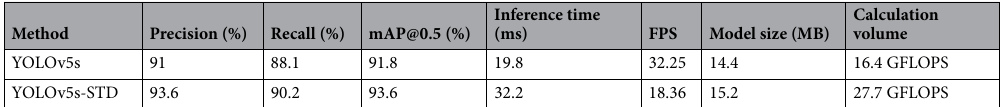
Table 9. Addition of the network model of a small target detection layer and the network performance test results of the original network model.